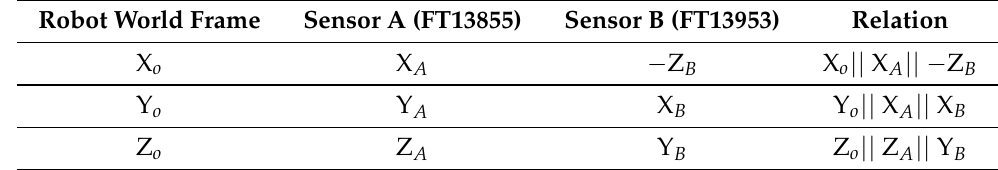
Table 3. Joystick frames when the robot is in Home configuration. Sensor A is always aligned with the robot end-effector frame.